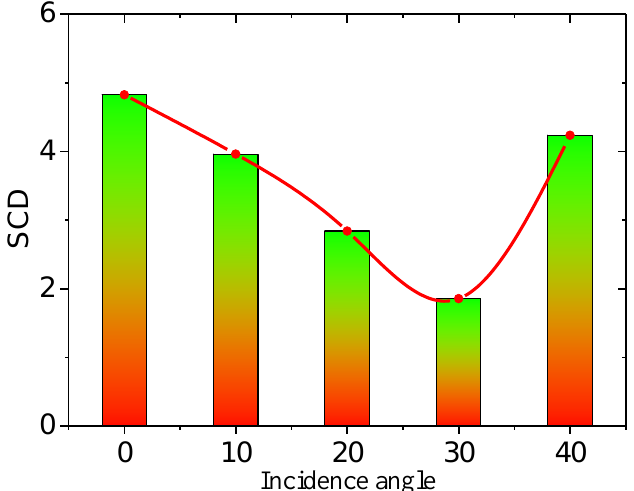
Figure 12. SCD of the pressure signal time series at different incidence angles.